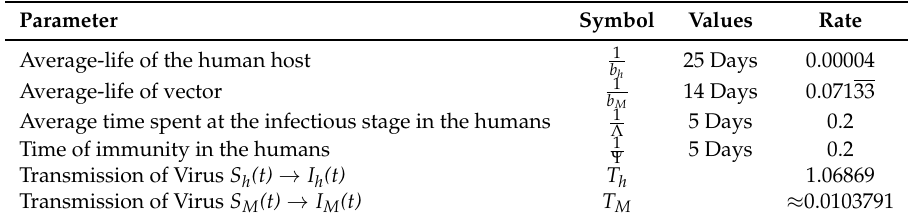
Table 1. Parameter values the mathematical model